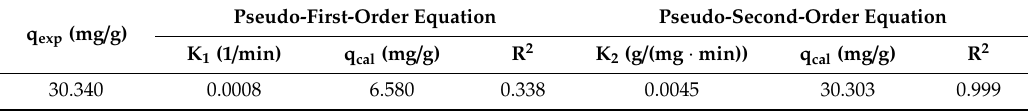
Table 2. Kinetics parameters for the adsorption of PRO onto GO / Fe 3 O 4 . q exp (mg /